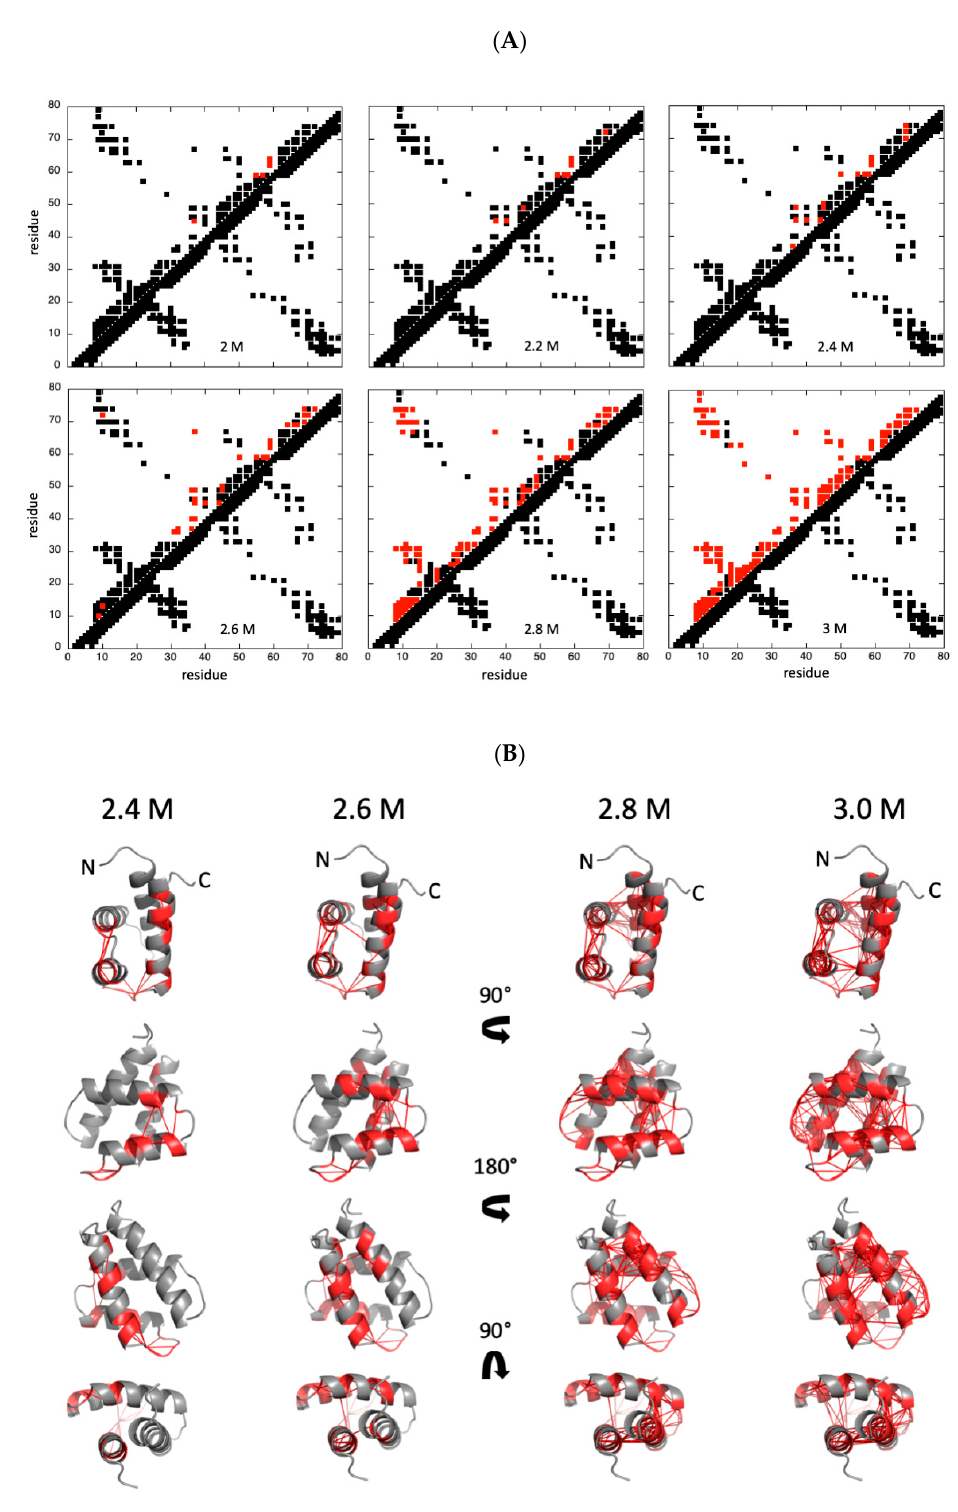
Figure 9. Chemical denaturation of GIPC1-GH2. ( A ) Contact maps built from the best solution structure obtained for GIPC1-GH2 at 20 °C, and at 2, 2.2, 2.4, 2.6, 2.8, and 3 M urea, as indicated. Contacts below and above the diagonal are displayed following the same rules as in Figure 6. ( B ) Visualization of the probabilities of contact on ribbon representations of GIPC1-GH2 at 20 °C and at 2.4, 2.6, 2.8, and 3 M urea, as indicated. The red lines represent contacts that are significantly weakened (P ij ≤ 0.5) at the indicated pressure. Residues involved in these contacts are also colored in red. The arrows in the middle of the panel indicate the rotation between the different